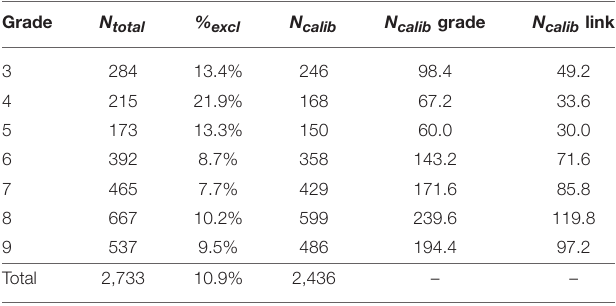
TABLE 4 | Overview of the calibration sample per grade: total sample, percentage of excluded students, and final calibration sample in total, for grade-specific items and for linking